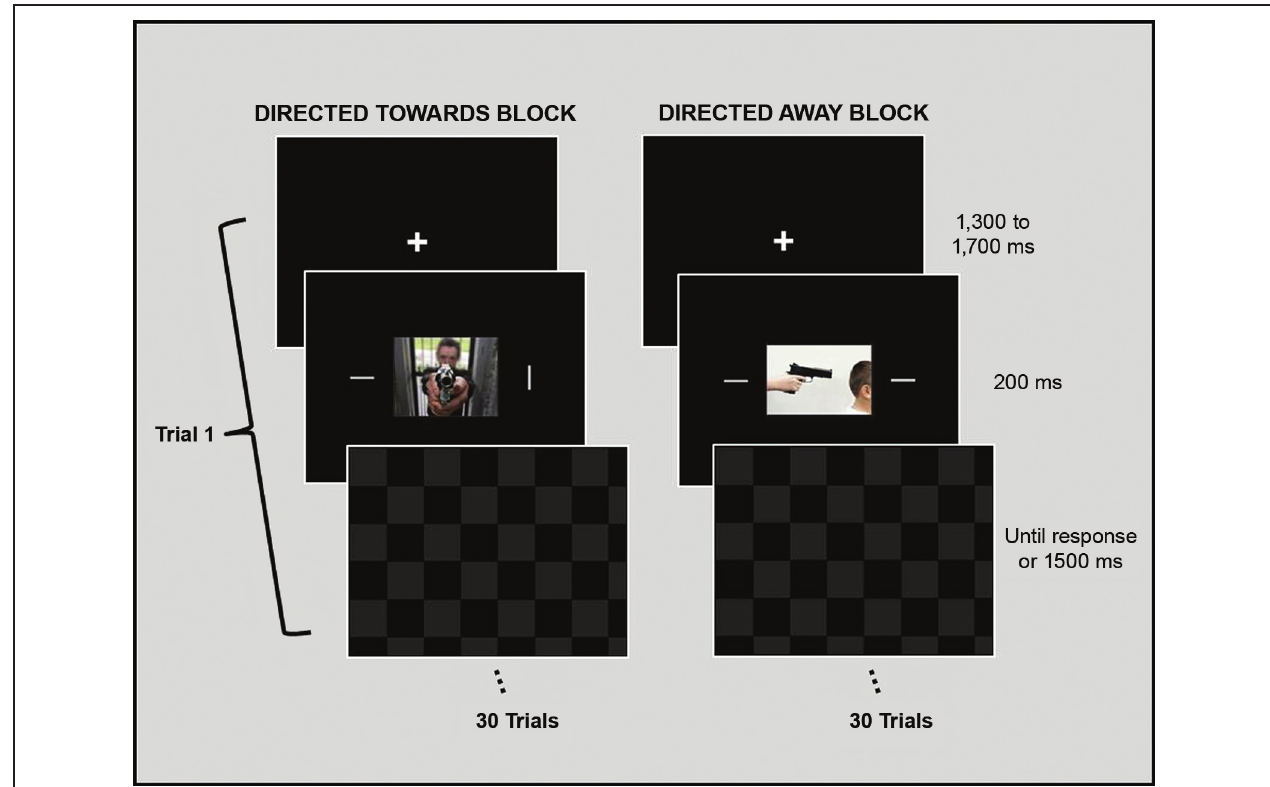
which was followed by a central picture and two peripheral bars, which were presented for 200 ms. A checkerboard mask then appeared and remained on the screen until the participant gave a response or the maximum amount of allotted time (1500 ms) passed. Participants were instructed to ignore the task-irrelevant central images and to respond as fast and as accurately as possible regarding the orientation of the peripheral bars by indicating whether the orientation of the bars was the same. Stimuli are not drawn to